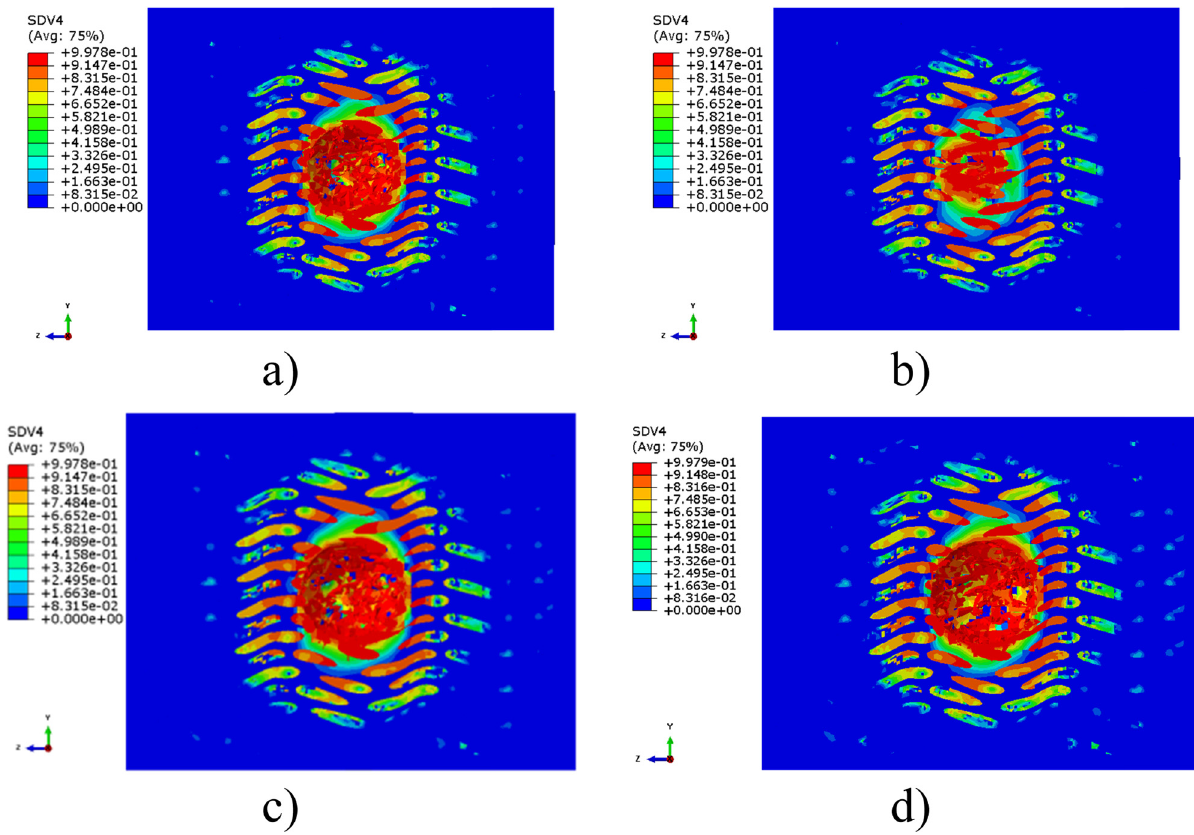
Figure 22: Transverse compression damage of the specimens after a di ff erent number of impact tests: ( a ) 1st impact, ( b ) 5th impact, ( c ) 10th impact, and ( d ) 20th